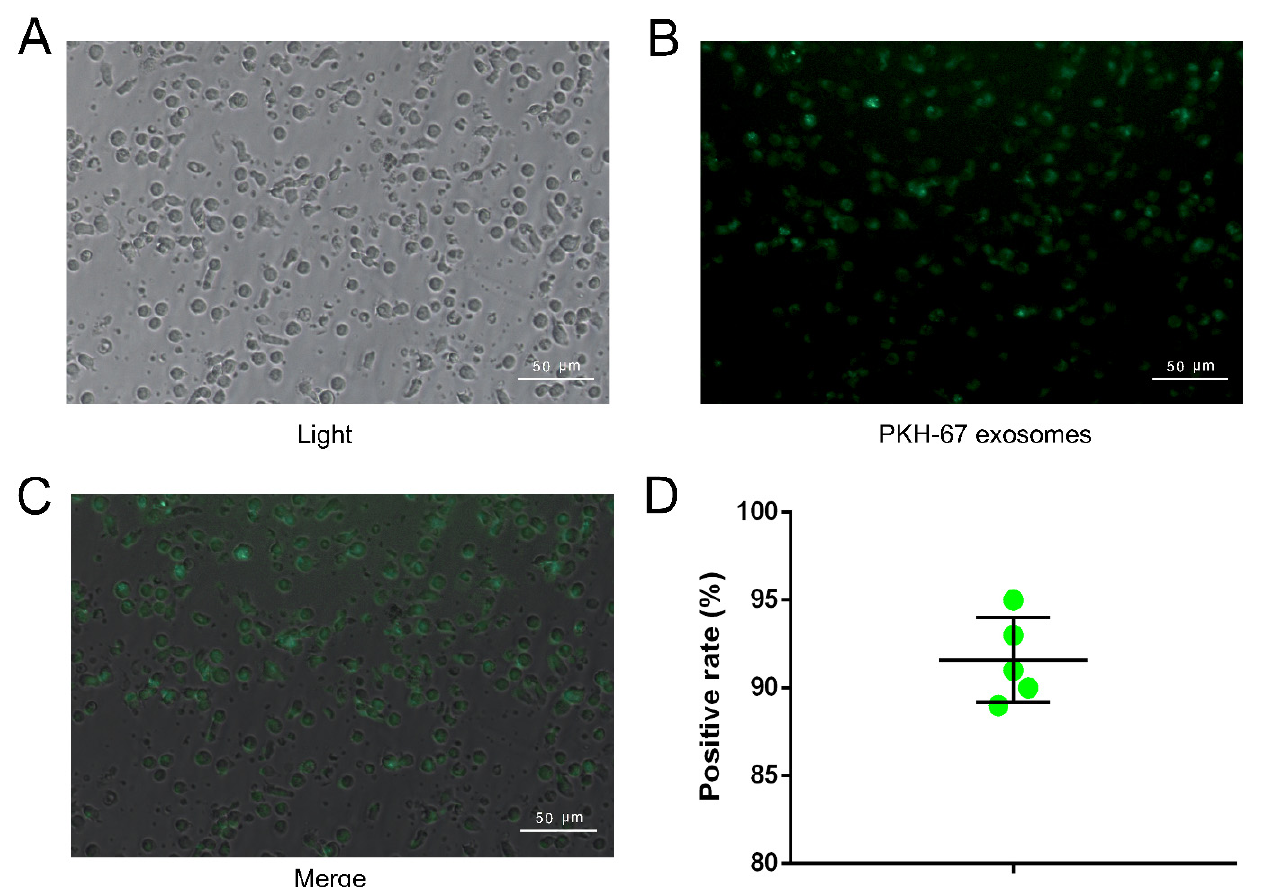
Figure 3. The exosomes uptake efficiency of NK cells. ( A ): The NK cells in light field. ( B ): The NK cells in fluorescence field, through uptake the Exo-Glow labeled T24 exosome, NK cell showed green fluorescent. ( C ): The positive rate of NK cells which showed green fluorescent tested by flow cytometry (n = 5). ( D ): The positive rate of NK cells.